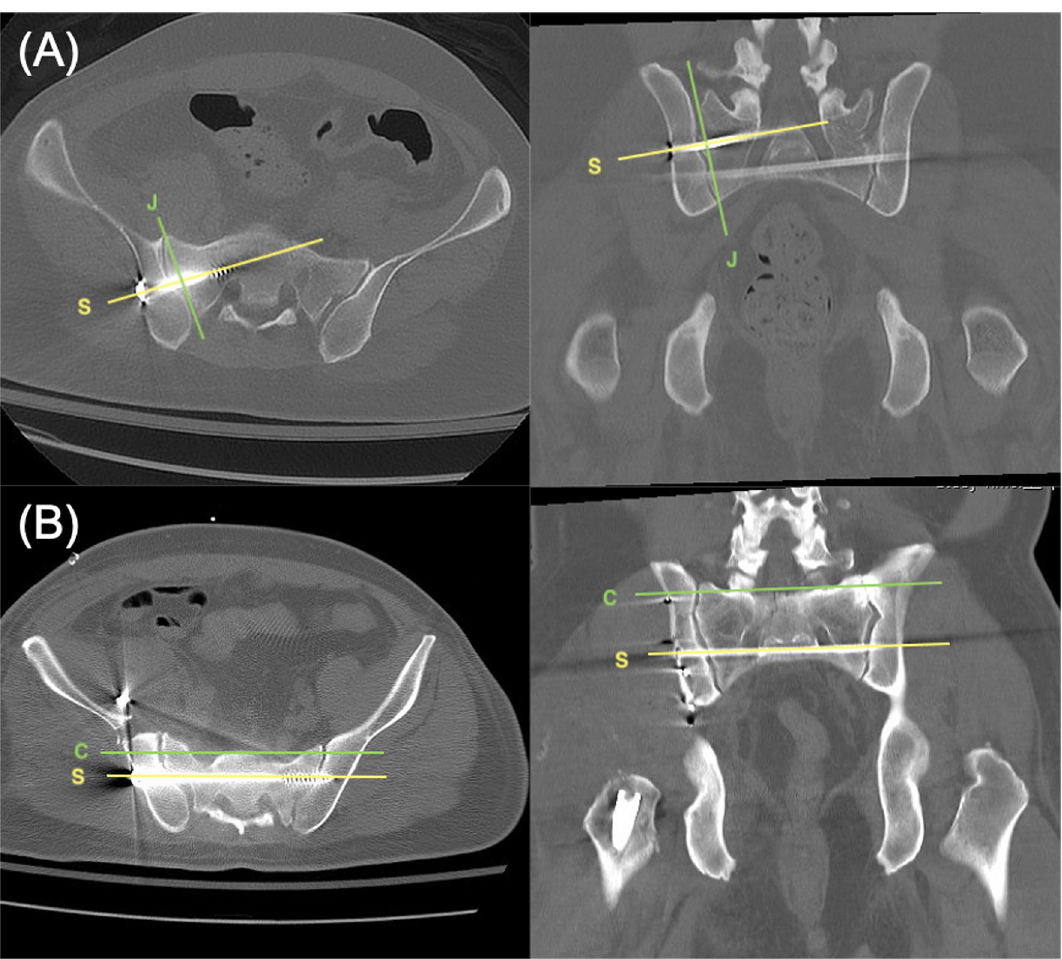
Figure 1. ( A ) The ideal angles between ISS (line S) and sacroiliac joint (line J) are 90° in both the axial and coronal views. The actual angles deviated from these ideal orientations are defined as the ADIO of ISS. ( B ) In both axial and coronal views, the ideal angle between TITS (line S) and groundline (line C) is 0°. The actual angles deviated from these ideal orientations are defined as the ADIO of TITS. ISS iliosacral screw, TITS trans- iliac trans-sacral screw, ADIO angle deviated from ideal orientation.